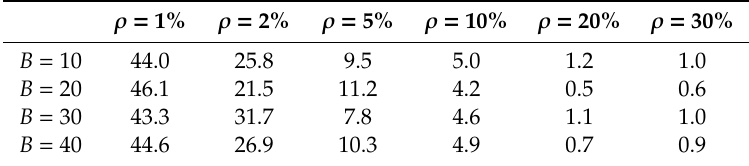
Table 1. Removal rate (in %) of the first filtering step of